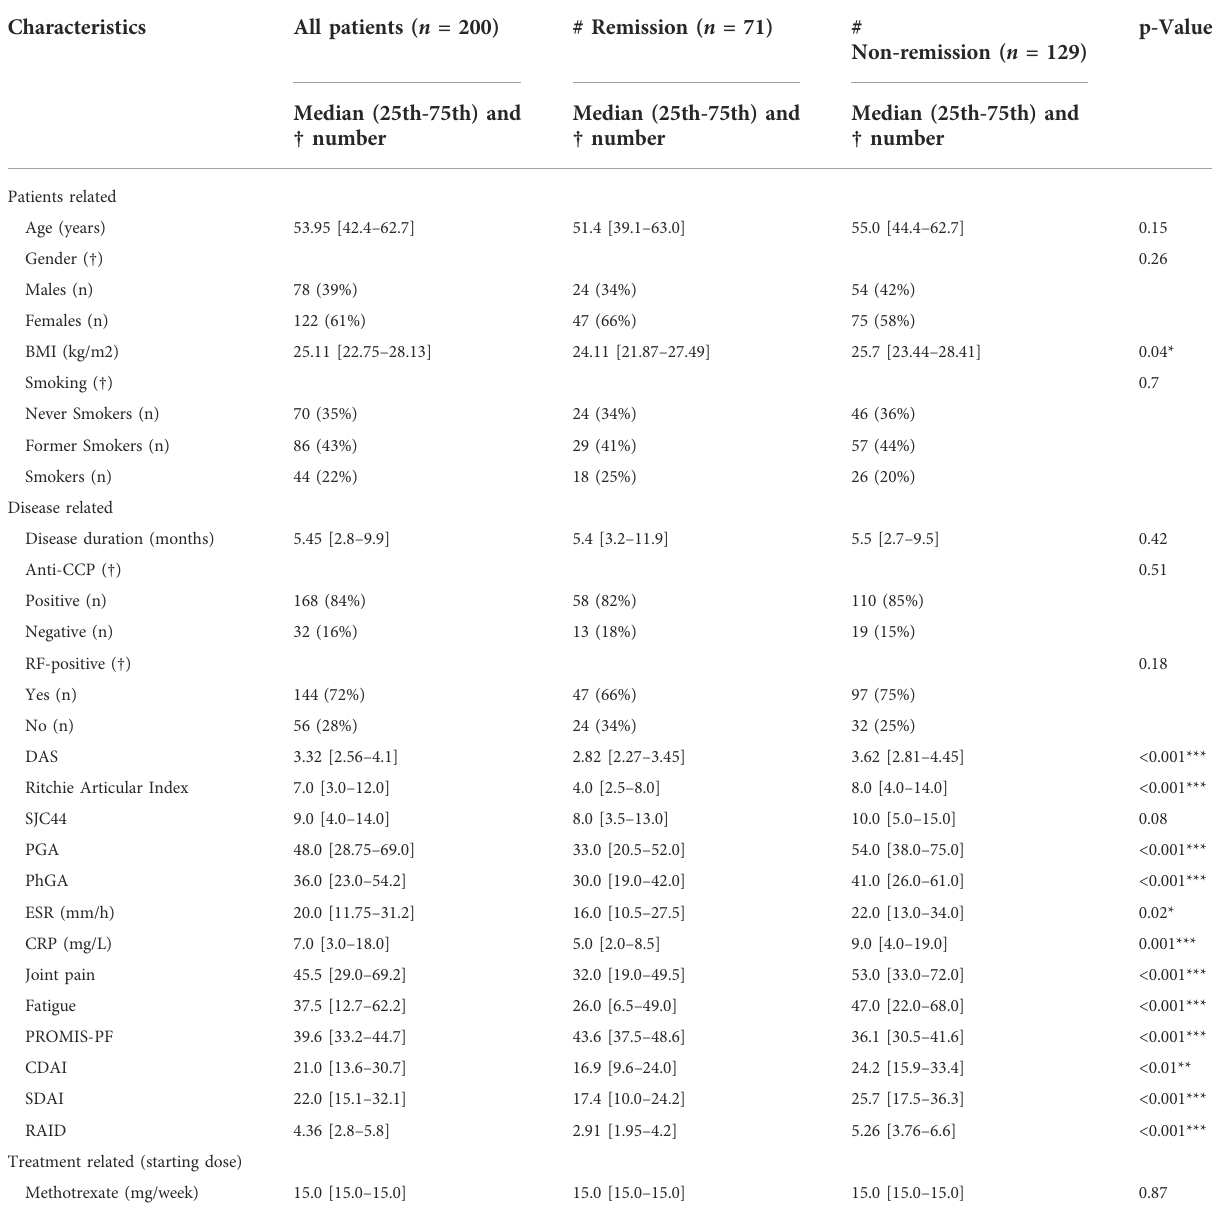
TABLE 1 Characteristics of the patients enrolled in the study.